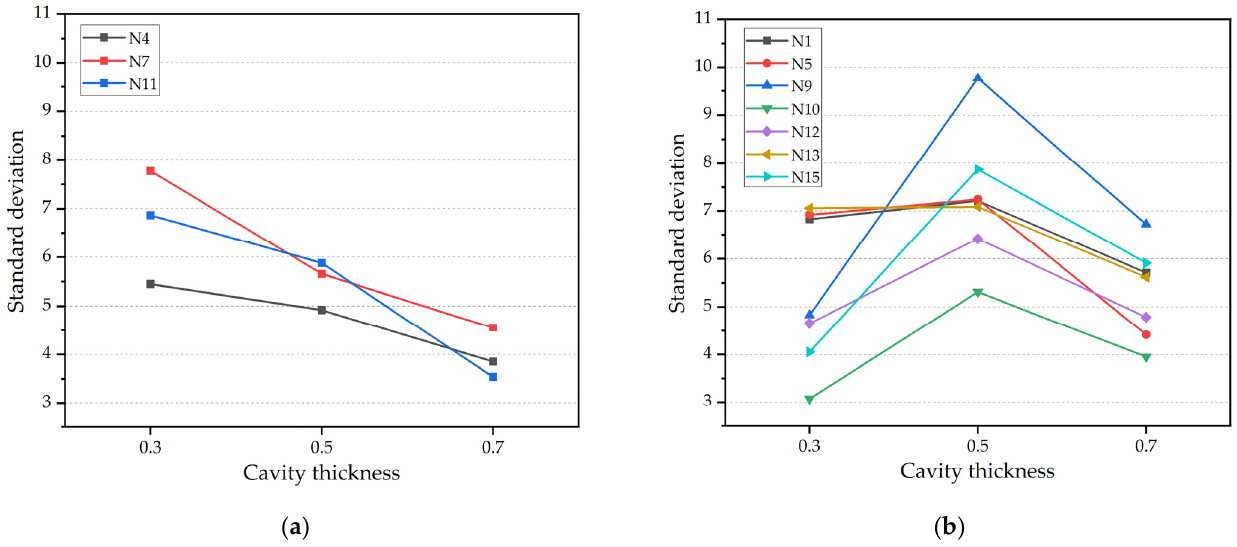
Figure 7. The relationship between cavity thickness and replication uniformity: ( a ) uniformity law under N4, N7, and N11; and ( b ) uniformity law under N1, N5, etc.